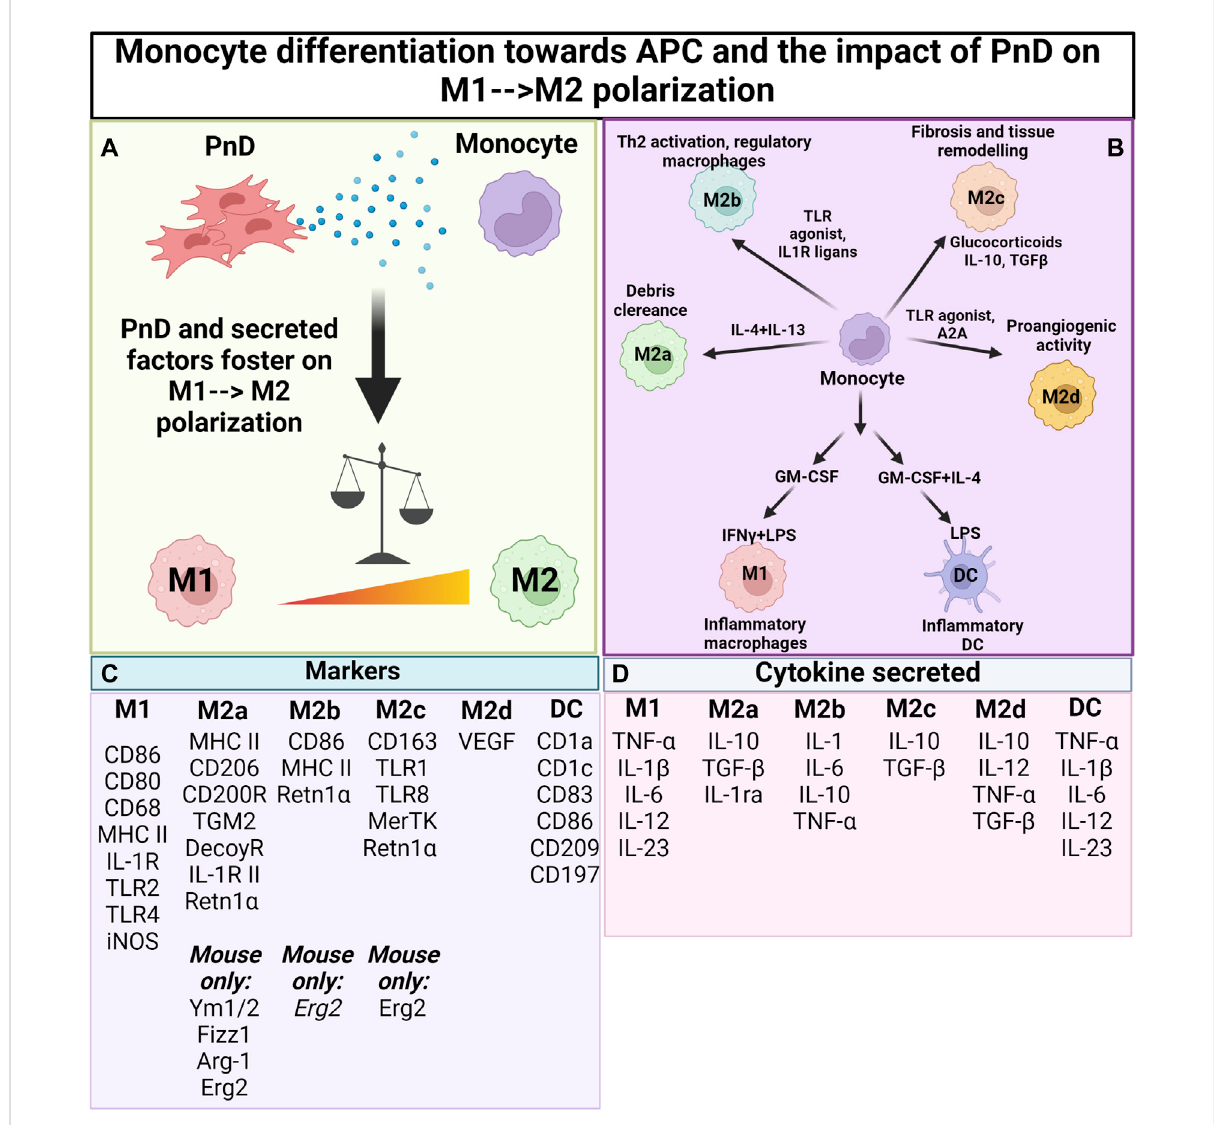
FIGURE 2 Impact of PnD on monocyte differentiation towards antigen presenting cells. (A) Perinatal Derivatives (PnD) and their secreted factors impact monocytedifferentiationtowardsantigenpresentingcellsfosteringtheacquisitionofphenotypeandfunctionalfeaturestypicalofM2macrophages. (B) Depending on the factors present in the microenvironment monocytes can be discriminated into different subsets of M2 macrophages (M2a, M2b,M2candM2d)eachofthembeingcharacterizedbypeculiarfunctions. (C) Summarytableforthemarkersspeci fi cformacrophageandDC subsets. (D) Summary table for the cytokines released by the different macrophage/DC subsets. (Created with